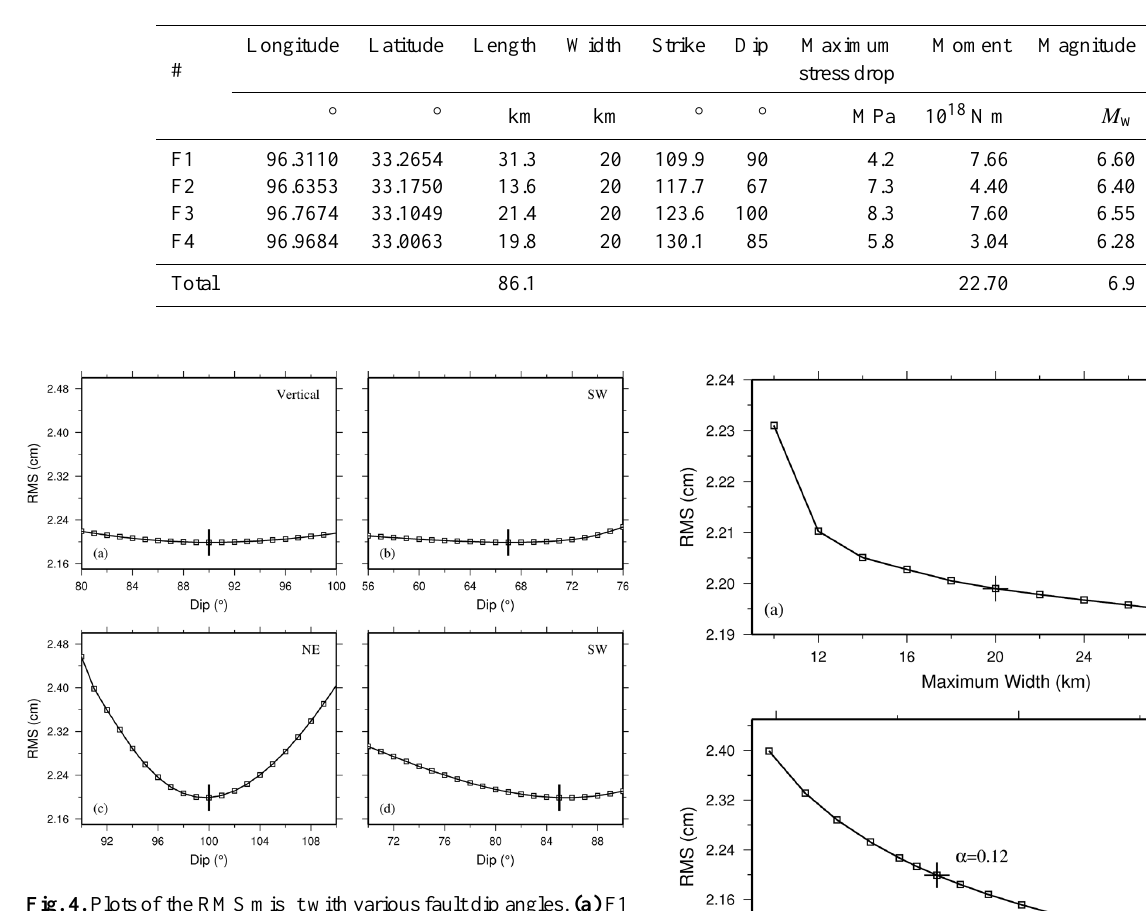
Table 2. Modeled fault parameters of Yushu earthquake.